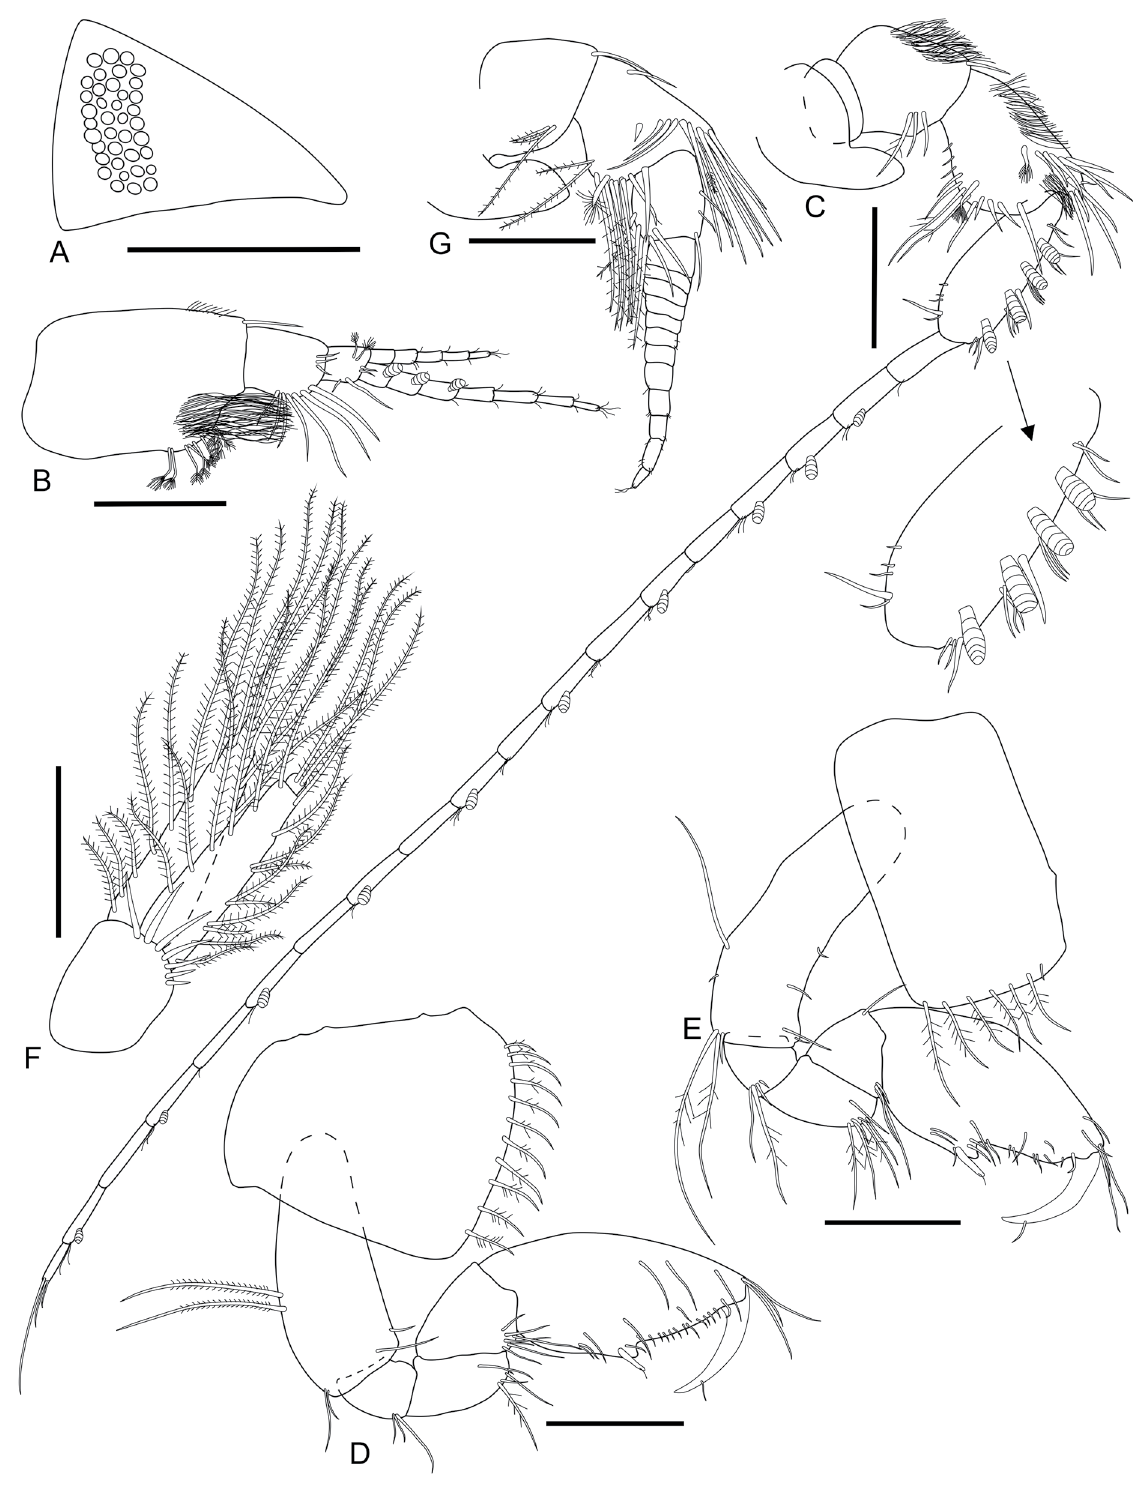
Fig. 6. Heterophoxus shoemakeri sp. nov. A–F . Paratype, ♂ (UERJ 434). A . Head. B . Antenna 1. C . Antenna 2. D . Gnathopod 1. E . Gnathopod 2. F . Uropod 3. G . Paratype, subadult ♂ (UERJ 435). Antenna 2. Scale bars: A = 0.5 mm; B–F = 0.2 mm; G = 0.1